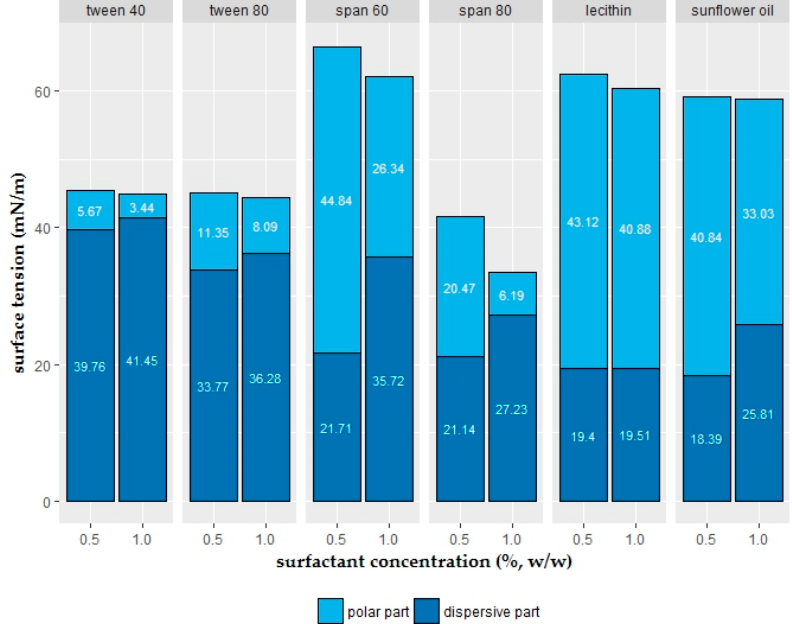
Figure 5. Effect of surfactant and oil type and concentration on polar ( γ LP ) and disperse ( γ LD ) part of the surface tension of coating solution. Each surfactant concentration was incorporated into 1.25% sodium alginate + 2% glycerol solutions ( n = 3).